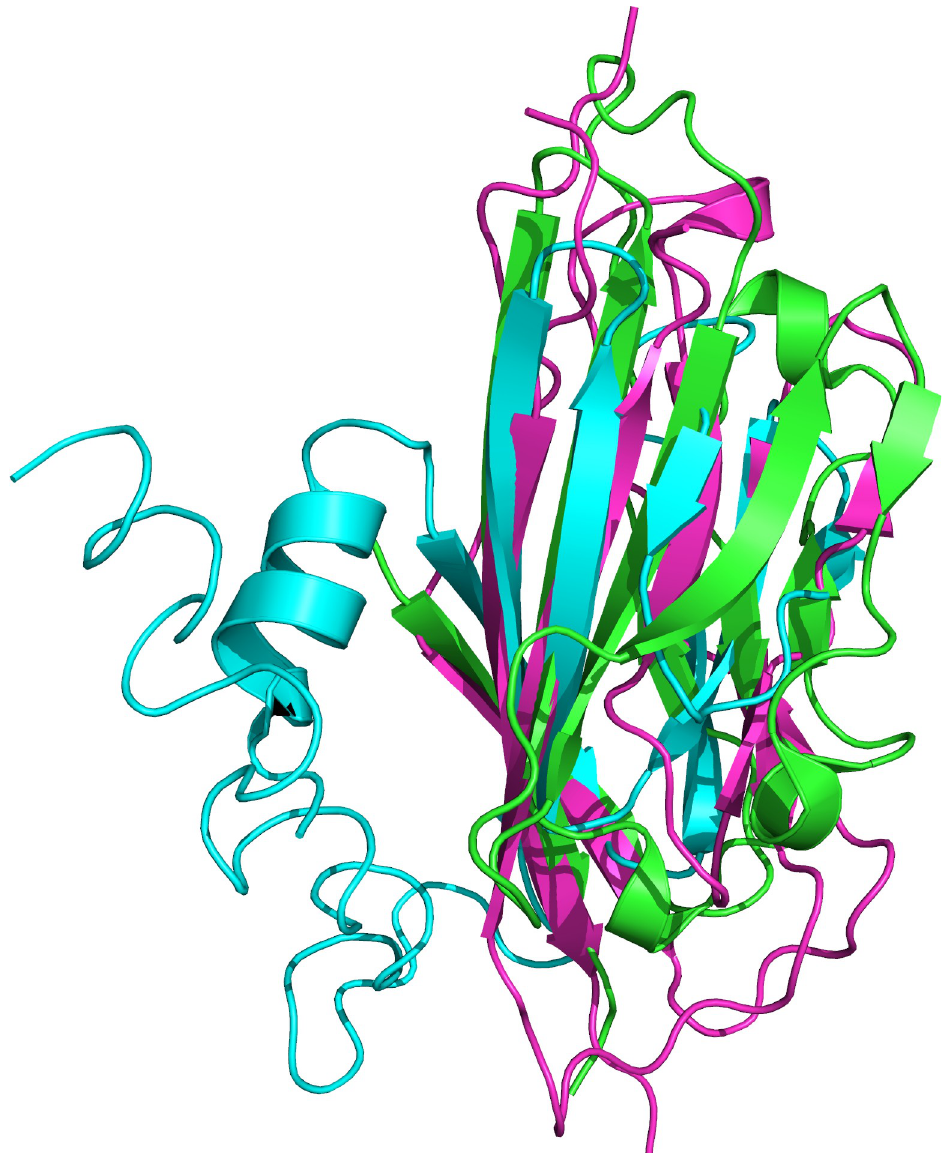
Fig 5. Structural alignment of ORF7a, CXADR, and PCDH1 proteins. The alignment is largely confined to the beta